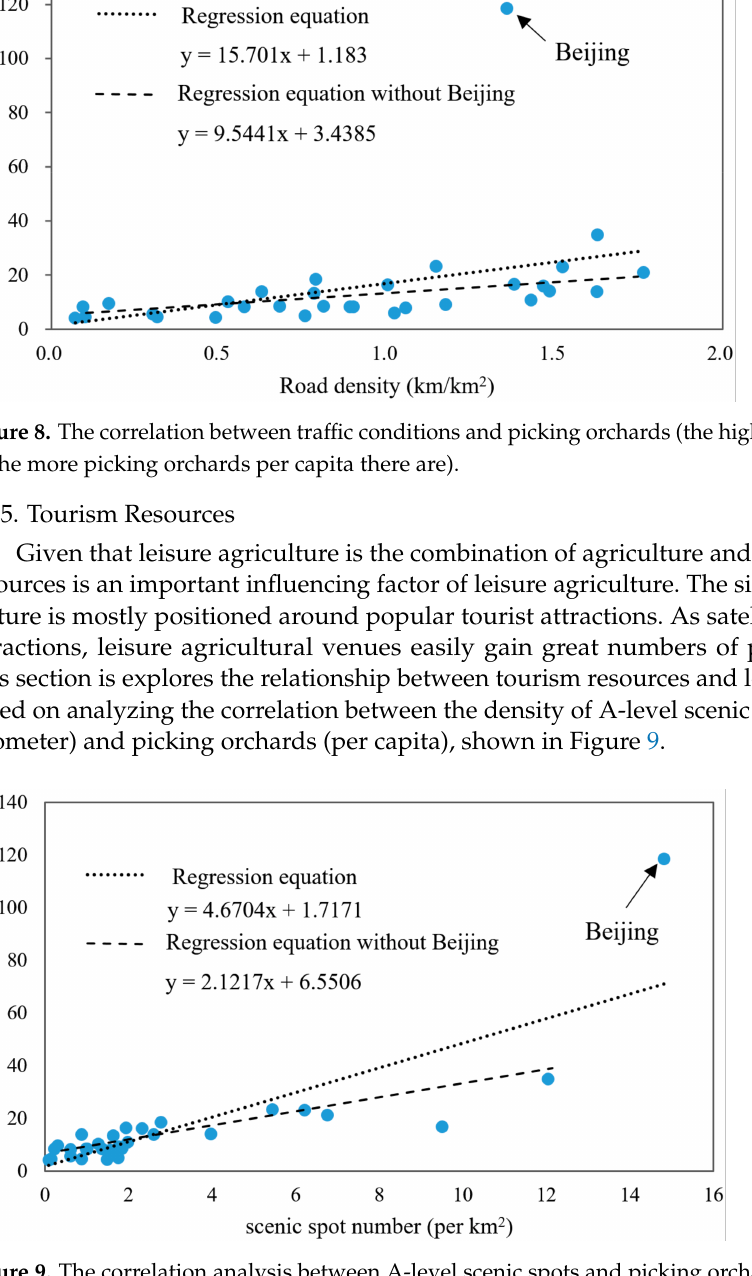
Figure 9. The correlation analysis between A-level scenic spots and picking orchards (the higher the density of A-level scenic spots is, the larger the number of picking orchards per capita